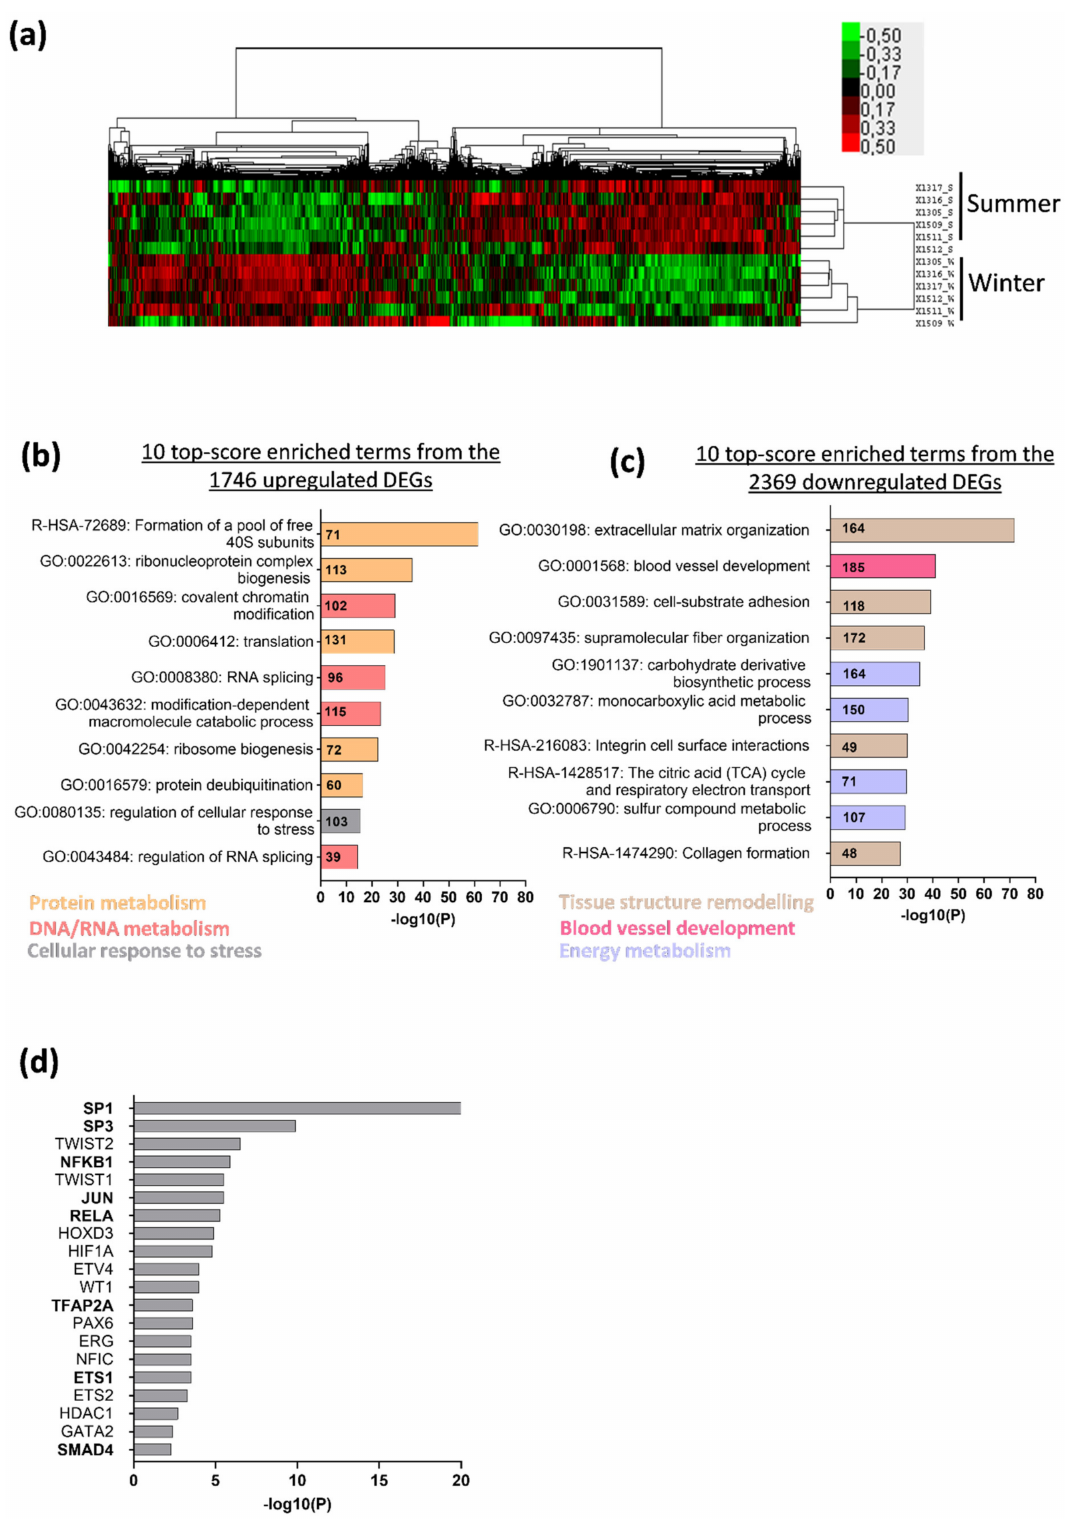
Figure 1. Deep changes in brown bear muscle transcriptome during hibernation. ( a ) Heatmap from brown bear muscle (vastus lateralis) transcripts ( n = 6 bears/season, the same individuals were sampled and analyzed in summer and winter); red indicates high and green indicates low expression level of the 13531 genes. ( b ) Graph representing the 10 top-score of significantly